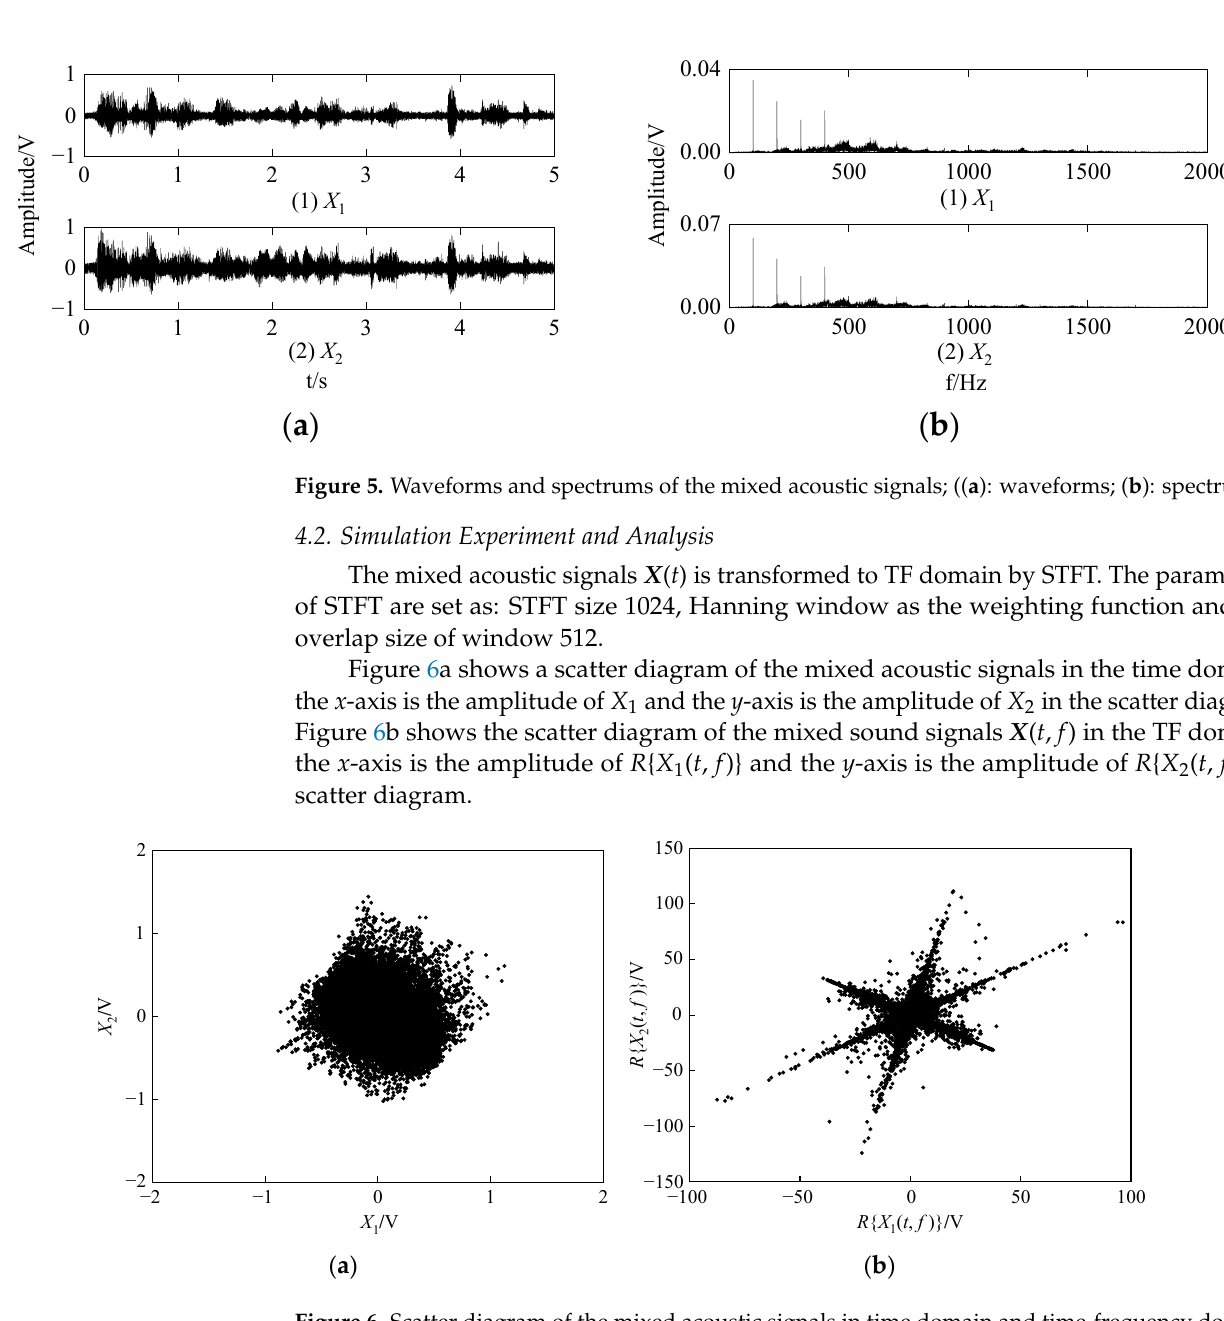
Figure 6. Scatter diagram of the mixed acoustic signals in time domain and time-frequency domain; (( a ): time domain; ( b ): time-frequency domain).